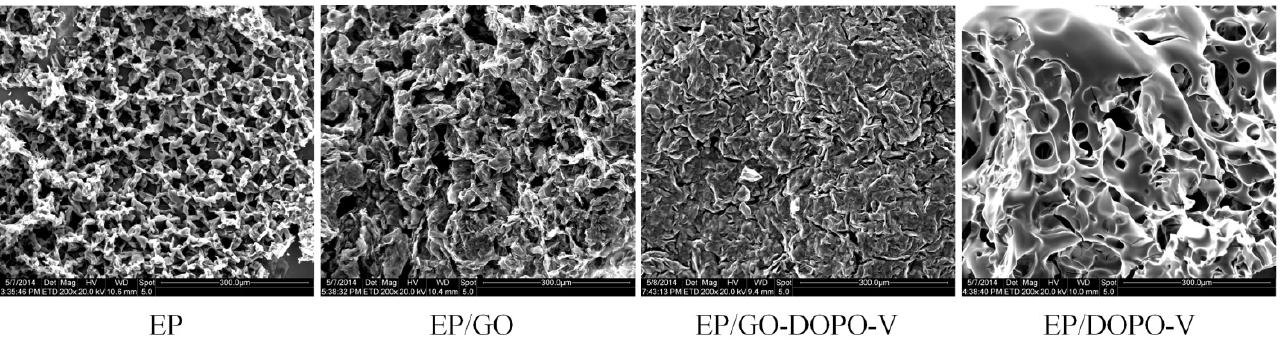
Figure 8. HRR ( a ) and THR ( b ) curves of EP, EP/GO, EP/DOPO-V and EP/GO-DOPO-V.